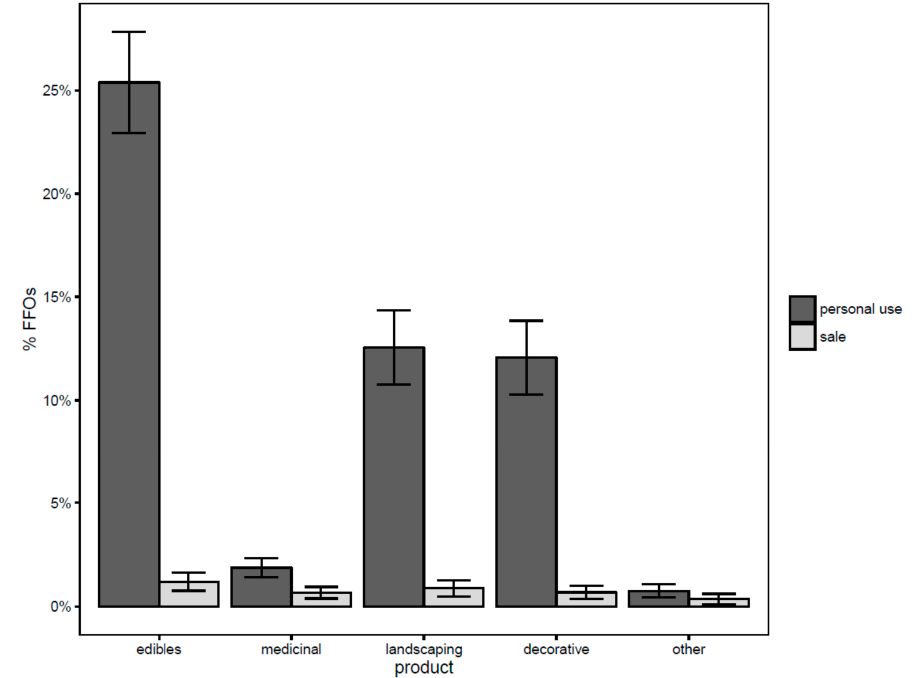
Figure 3. Estimated proportion of family forest ownerships (4+ ha) producing non-timber forest products (NTFPs), by product type and beneficiary, United States, 2011–2013. Error bars represent two standard errors.